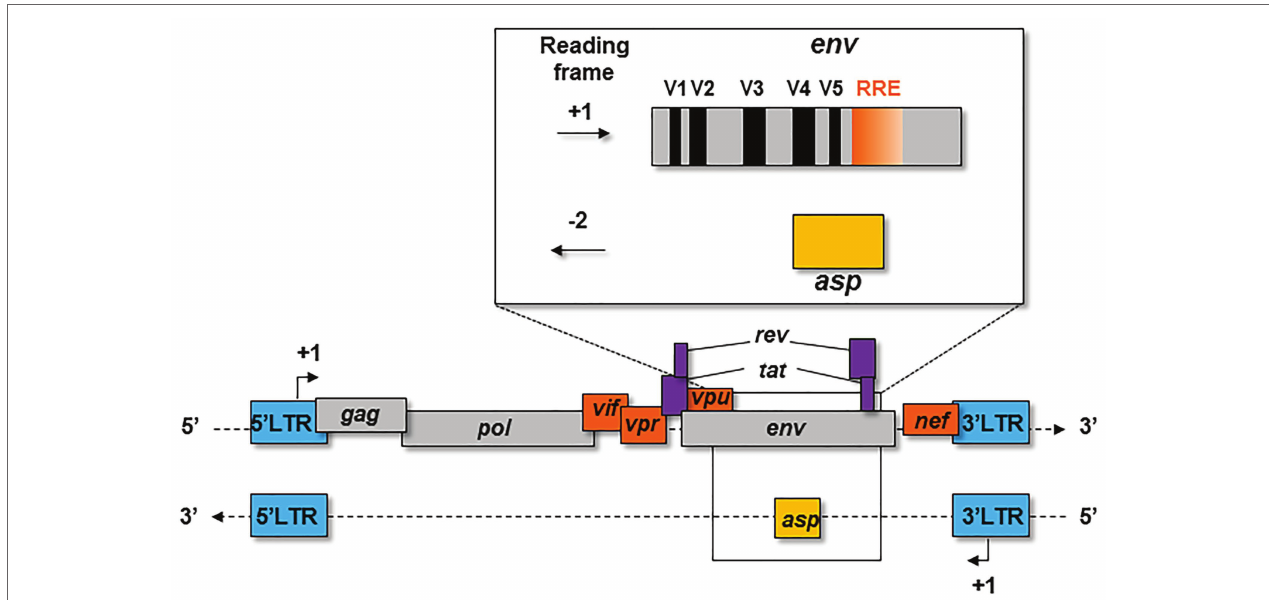
FIGURE 1 | Schematic representation of the asp gene within the proviral genome of HIV-1. The asp gene overlaps the env gene in the − 2 frame. The asp gene overlaps the hypervariable regions V4 and V5 of env and partly overlaps the Rev Responsive Element